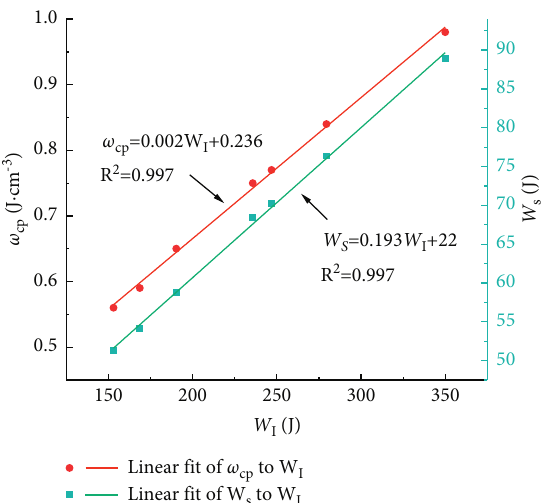
Figure 10: Relationship between specific energy absorption values with absorbed energy and incident energy.